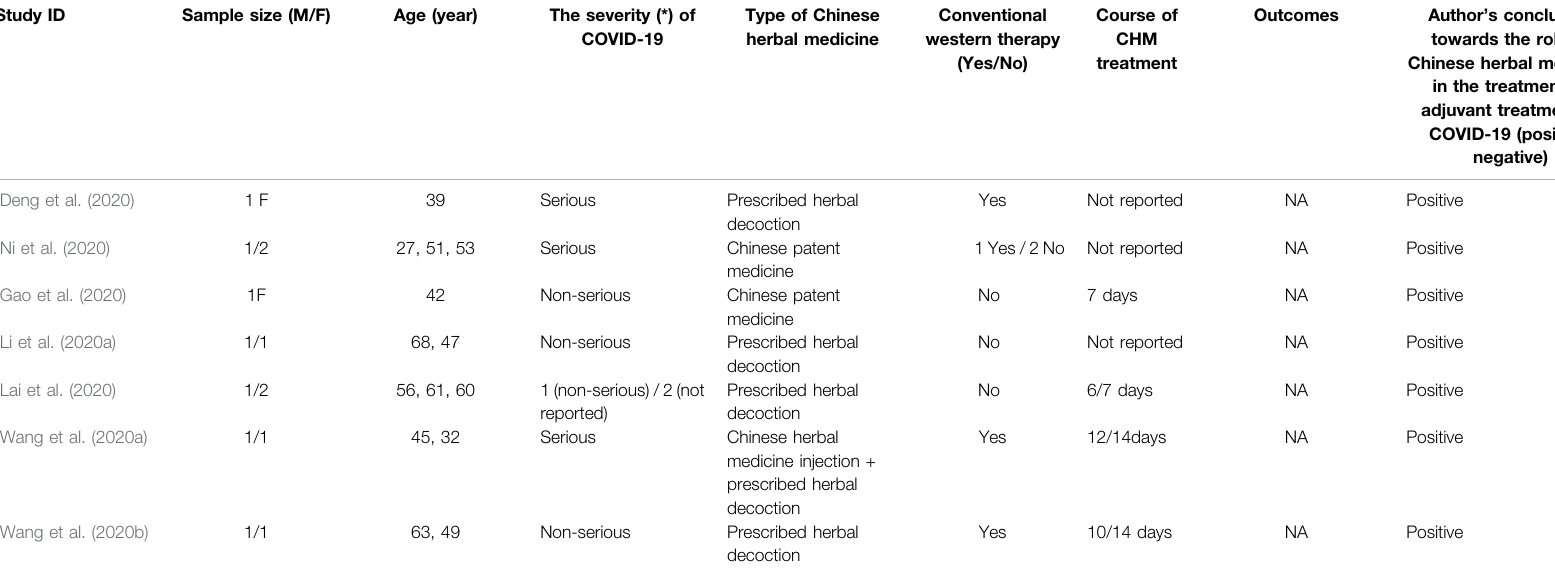
TABLE 1 | ( Continued ) The characteristics of included studies of Chinese herbal medicine for